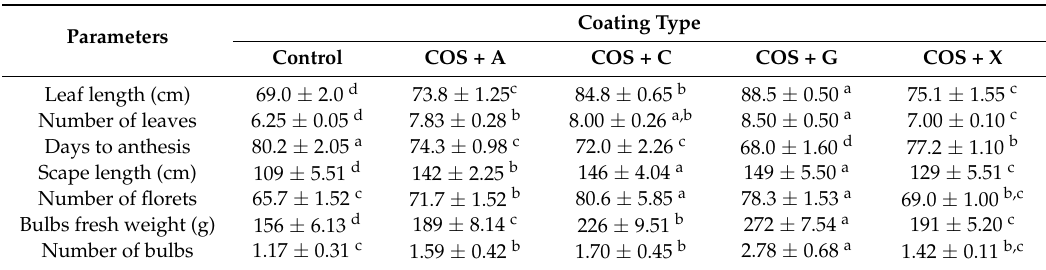
Table 1. Effects of COS coating combined with selected ionic polymers on plant growth of Ornithogalum saundersiae